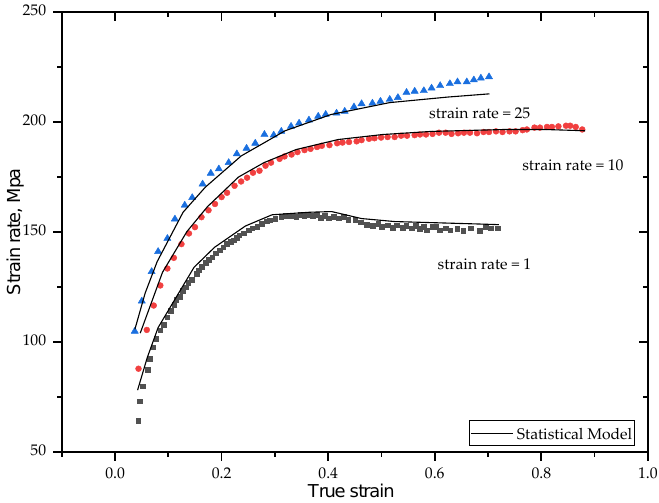
Figure 4. Constitutive model stress — specific deformation of the steel.